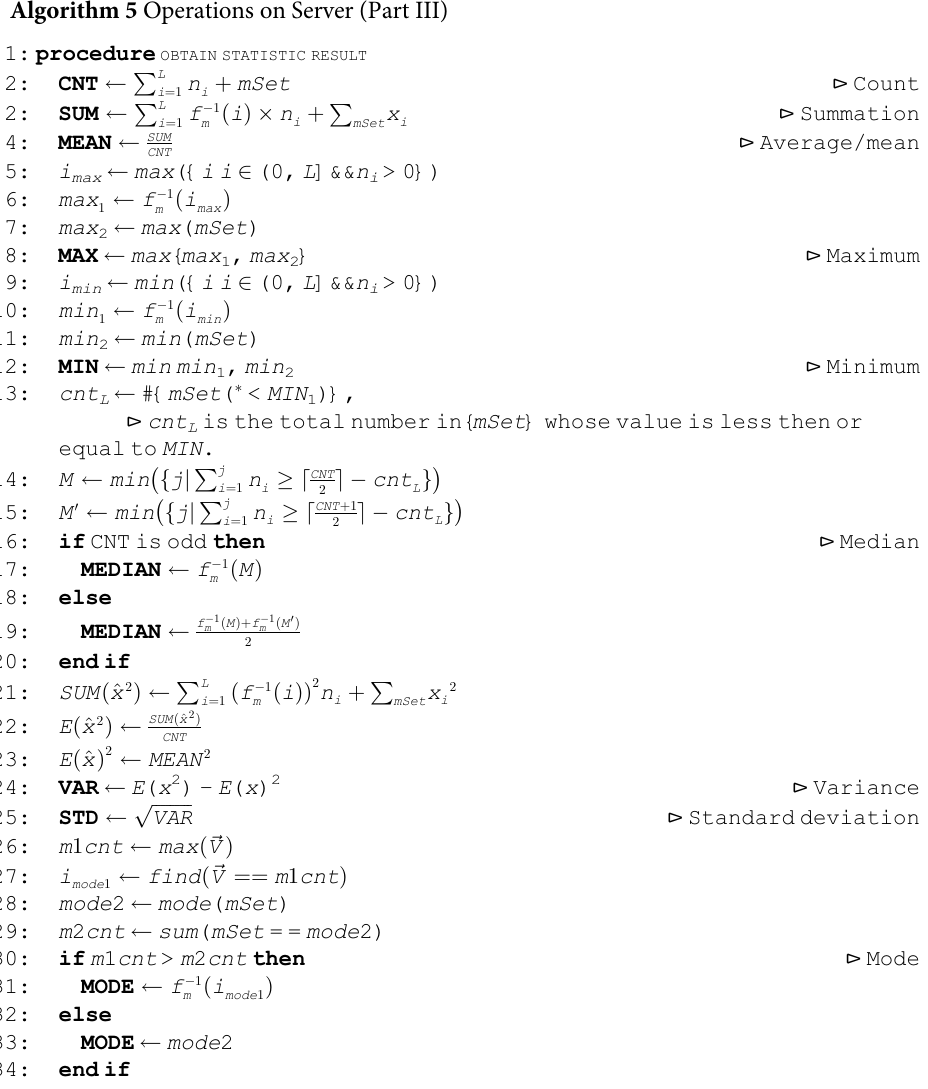
Algorithm 5 Operations on Server (Part